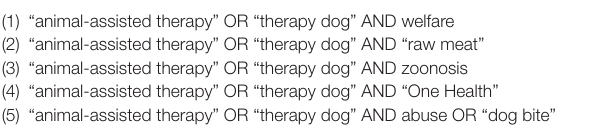
TABLE 1 | Search string used in Google Scholar, Web of Science, PubMed.